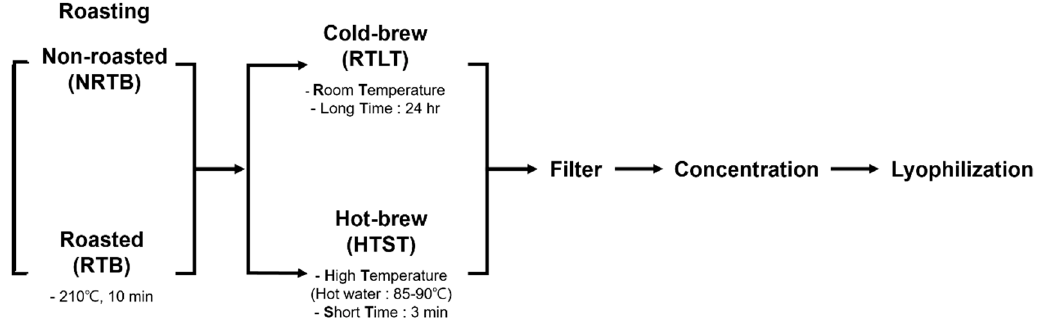
Figure 1. Schematic of the preparation of Tartary buckwheat (TB) teas.